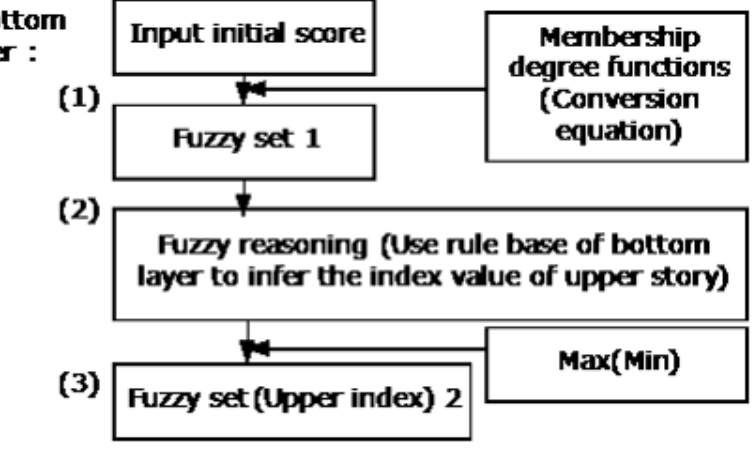
Figure 3. Computing the bottom index value of FLI-GA model